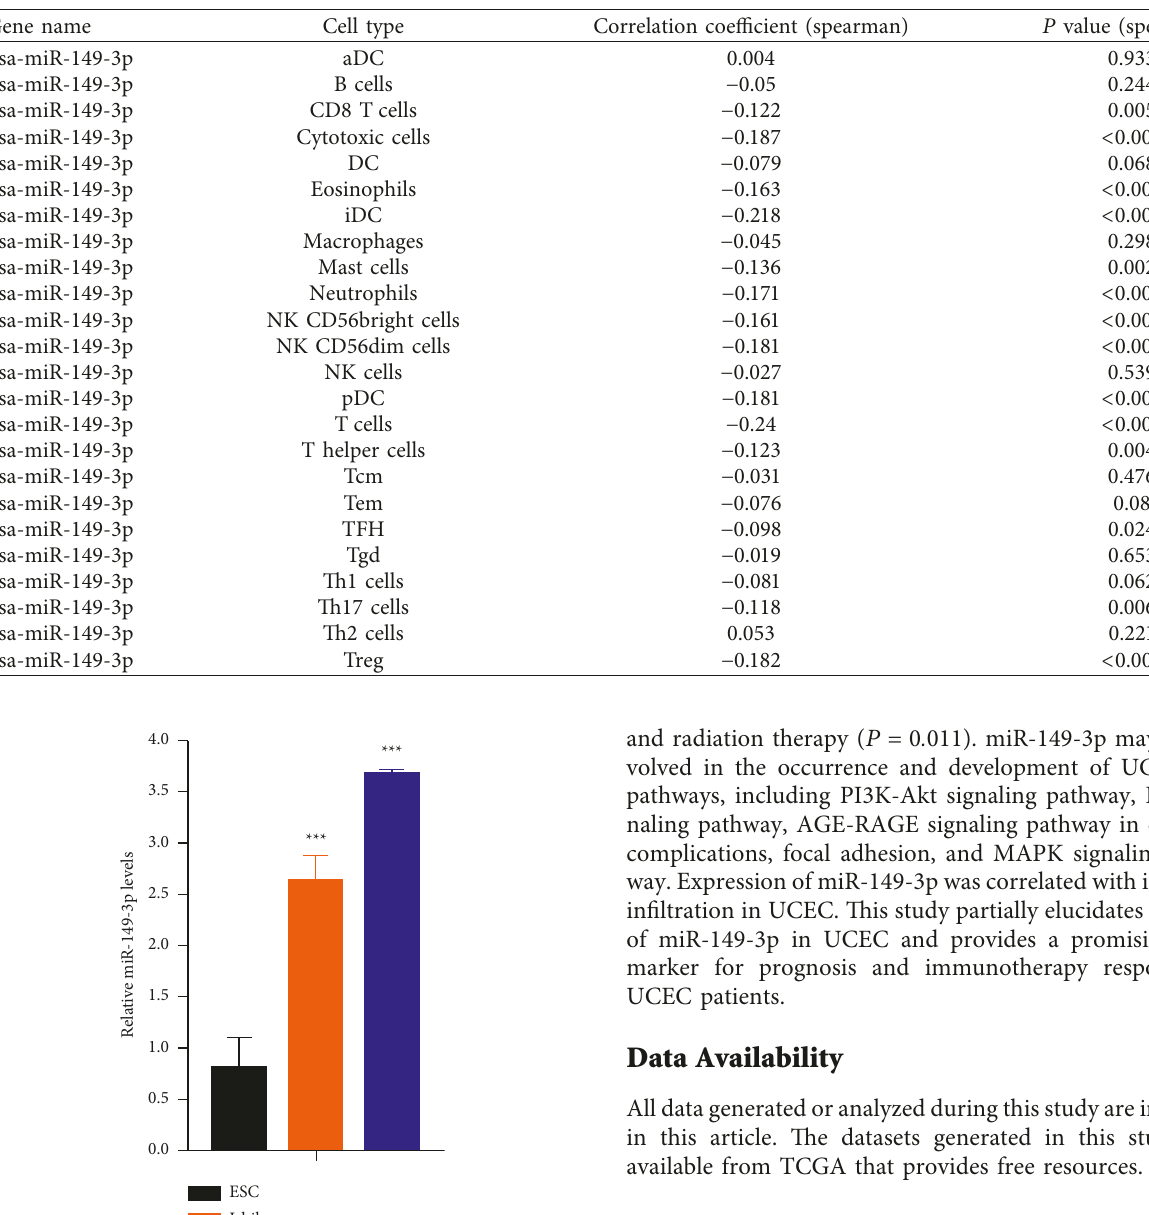
Table 5: Expression of miR-149-3p in relation to immune cells (spearman method).